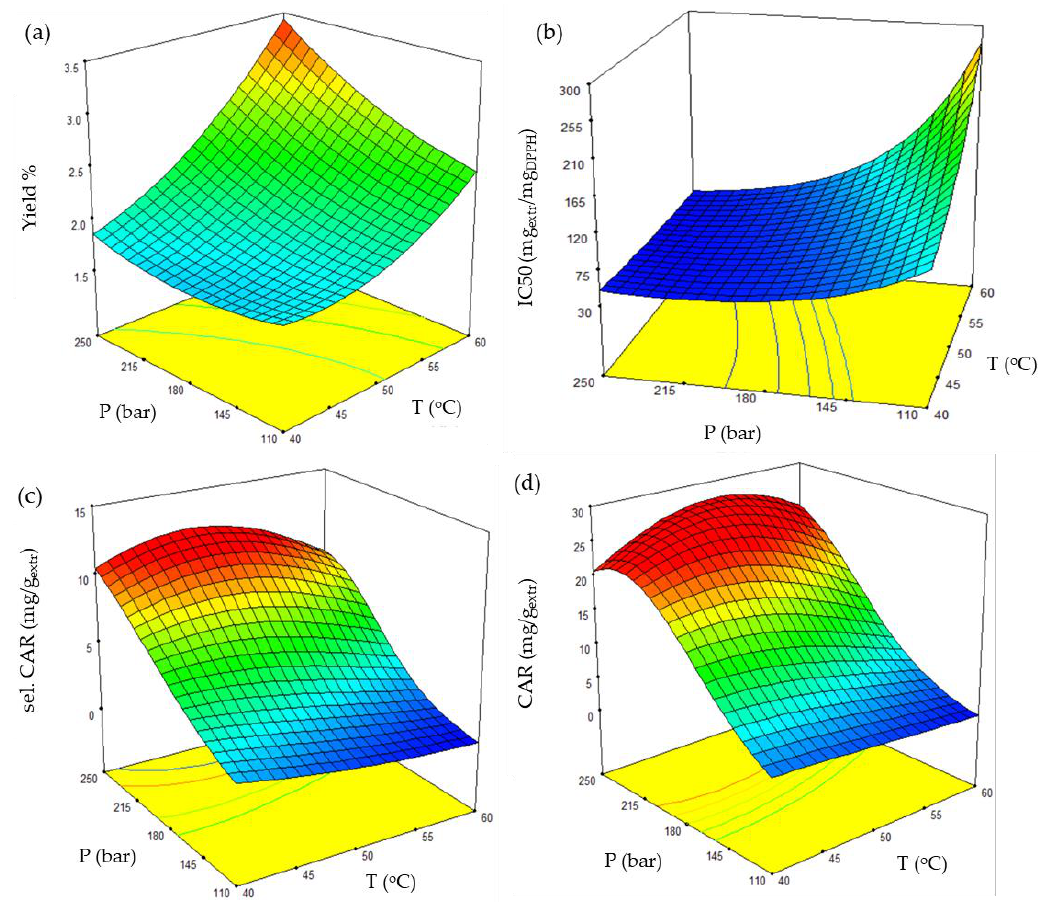
Figure 6. 3-D plots presenting the combined effect of pressure and temperature on ( a ) yield, ( b ) antioxidant activity, ( c ) selected and ( d ) total carotenoid content. Solvent flow rate is set at 40 g/min.